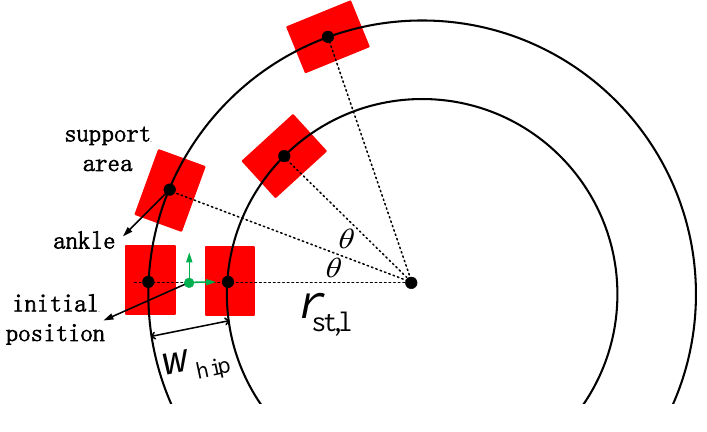
Figure 7. Foot position